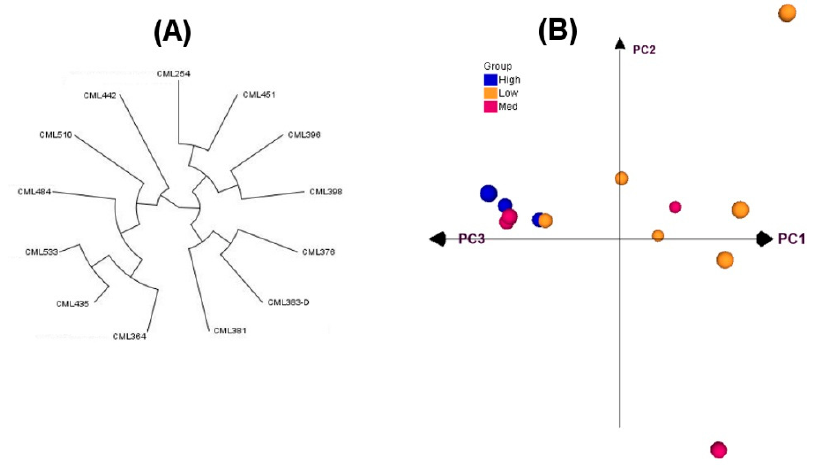
Figure 1. Dendrogram ( A ) and principal component analyses ( B ) of 13 International Maize and Wheat Improvement Center (CIMMYT) maize lines (CMLs) based on modified Rogers’ distances estimated using 10,000 Genotyping by Sequencing (GBS) markers.